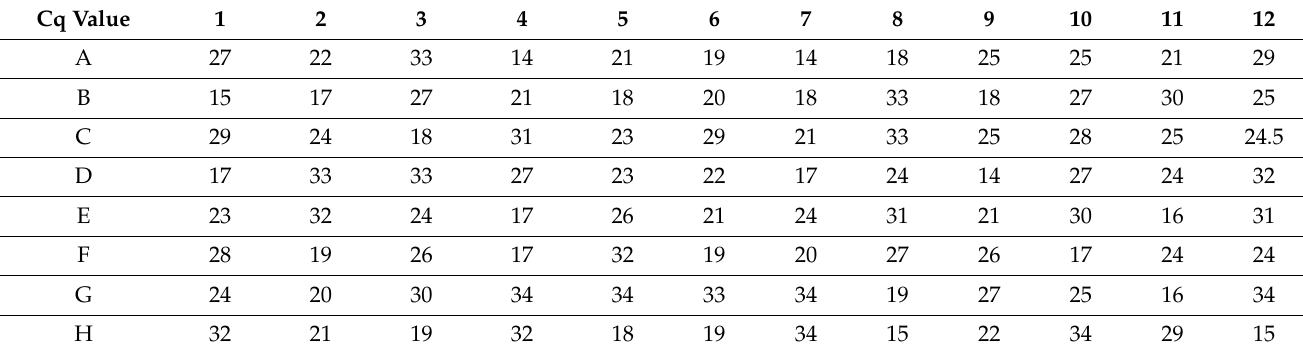
Table 1. Clinical RNA plate with Cq value from RT-PCR assay.